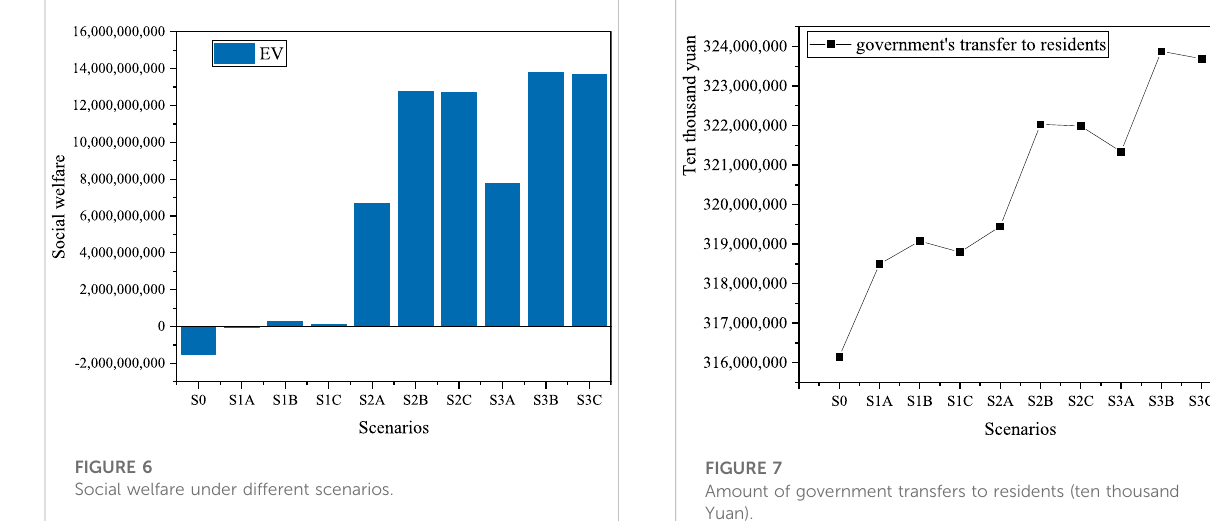
FIGURE 6 Social welfare under different scenarios.